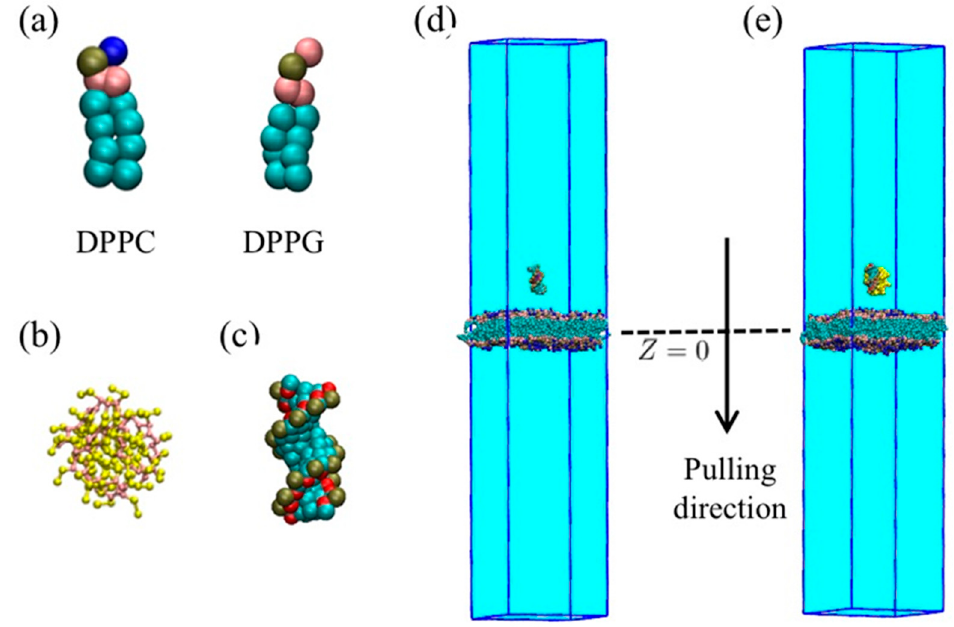
Figure 9. Models of lipid, siRNA, and lipid bilayer membrane. ( a ) Coarse-grained model of DPPC and DPPG, here choline group was colored in blue, phosphorus group was colored in brown, glycerol group was colored in pink and fatty acid chain was colored in cyan; ( b ) coarse-grained model of PMAL, here backbone is colored in pink, side chain is colored in yellow; ( c ) coarse-grained model of siRNA, here red beads are sugar particles, cyan beads are base particles, green beads are phosphate particles; ( d ) model of the naked siRNA transmembrane; ( e ) model of siRNA-PMAL complex transmembrane.